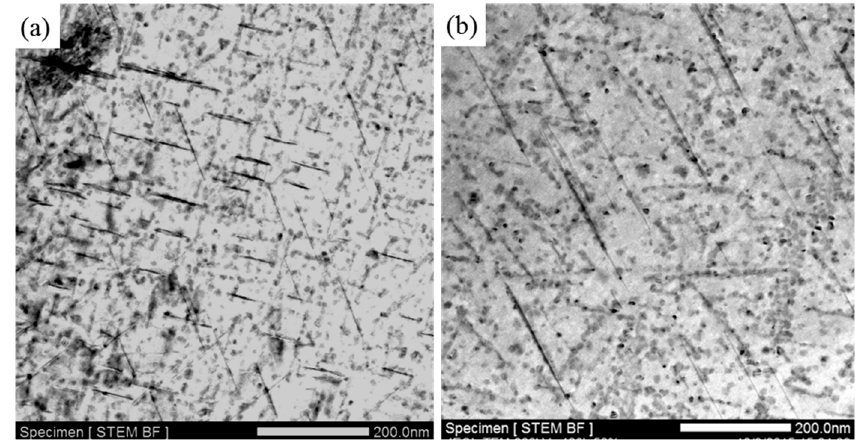
Figure 6. The precipitate characteristics of ( a ) Ce-containing and ( b ) Ce-free alloys after exposure at 120 ° C for 1300 h. 120 ° C for 1300 h. 120 ◦ C for 1300